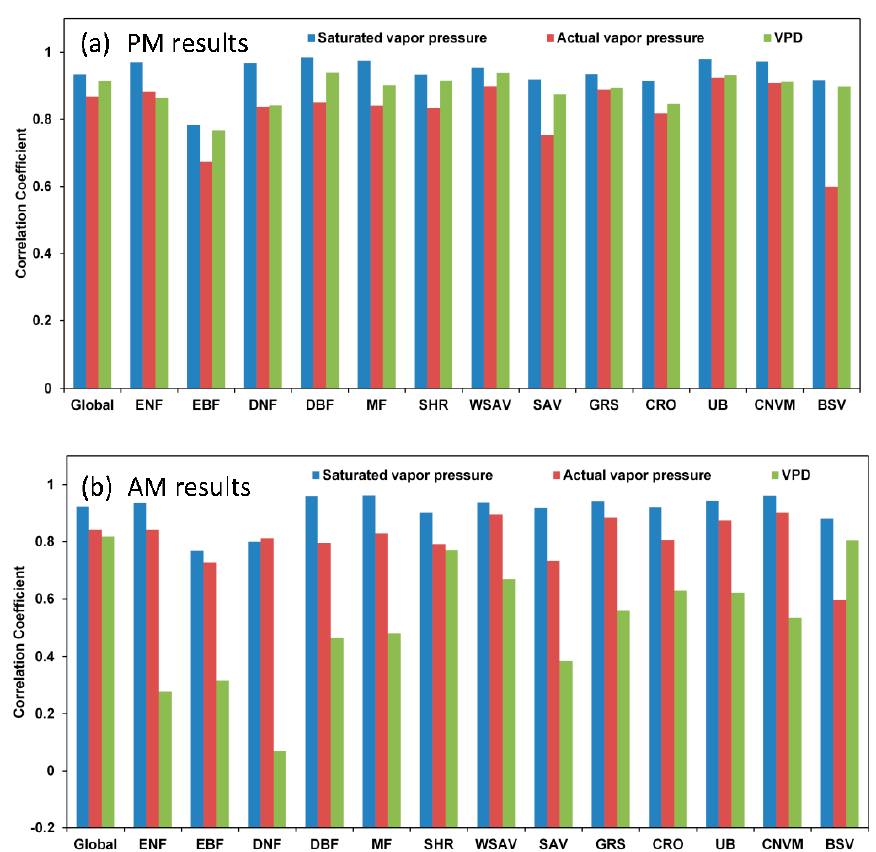
Figure 6. Correlations between the Advanced Microwave Scanning Radiometer (AMSR) Land Parameter Data Record (LPDR) ( a ) p.m. and ( b ) a.m. estimates and Integrated Surface Global Hourly (ISH) station observations of saturation vapor pressure ( e s ), actual vapor pressure ( e a ), and Vapor Pressure Deficit (VPD) for 2010 over the global domain and major land cover classes including ENF—Evergreen Needleleaf forest; EBF—Evergreen Broadleaf forest;